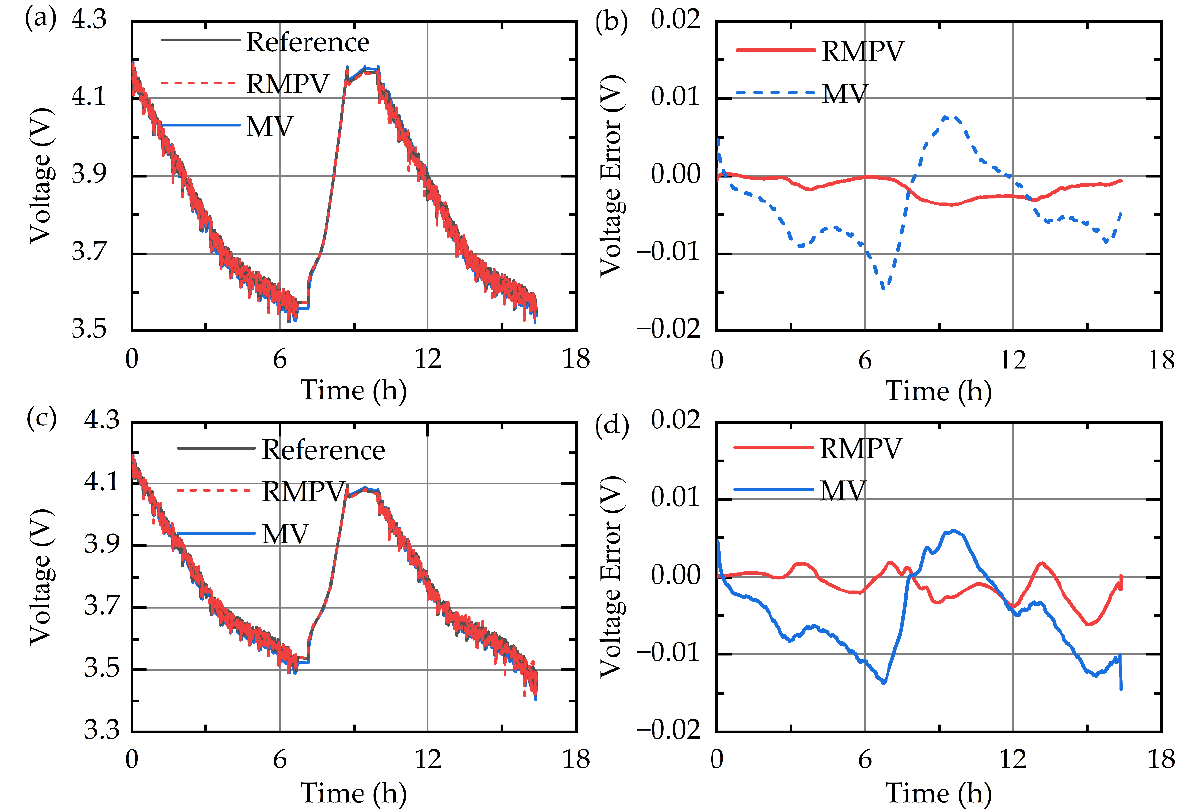
Figure 7. Performance of the proposed reconstruction method for the model-predicted voltage of the ISC battery: ( a ) reconstruction result during the 100 Ω -ER test; ( b ) voltage error relative to the reference value during the 100 Ω -ER test; ( c ) reconstruction result during the 10 Ω -ER test; ( d ) voltage error relative to the reference value during the 10 Ω -ER test.